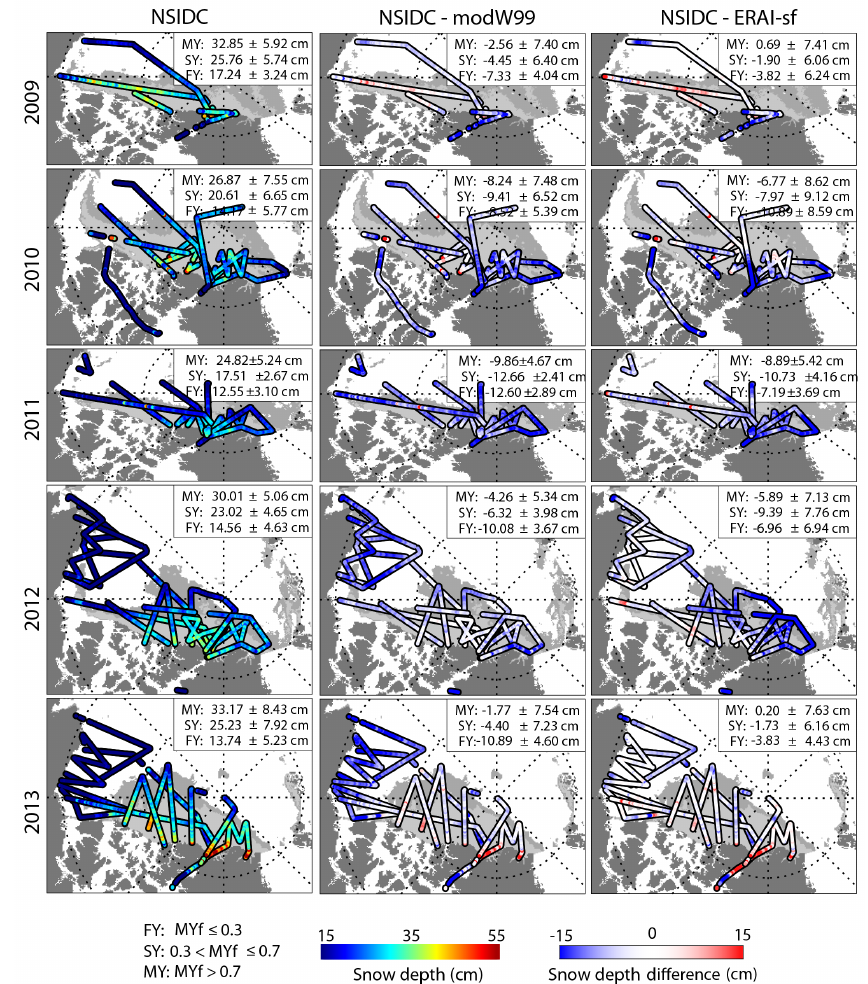
Figure 12. Comparison of NSIDC snow depth retrievals with ERAI-sf and the